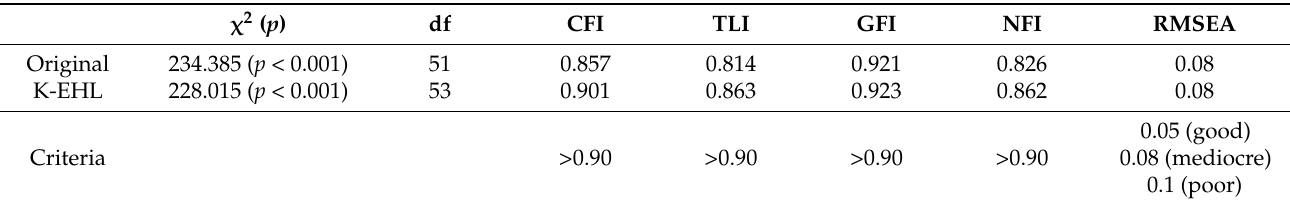
Table 3. Indices of fit for the original model and the Korean version of the Environmental Health Literacy (K-EHL) Scale model.